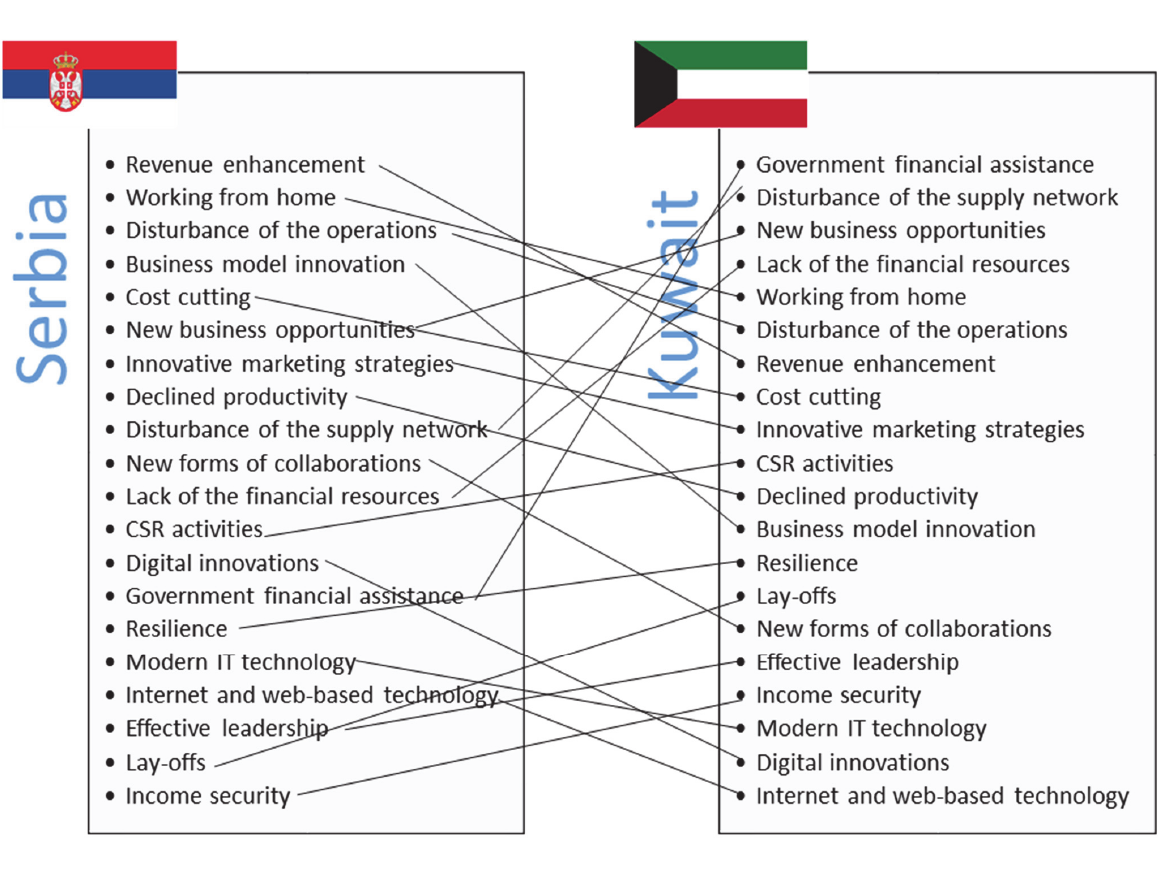
Fig. 2. A complex pattern of COVID-19 effects on